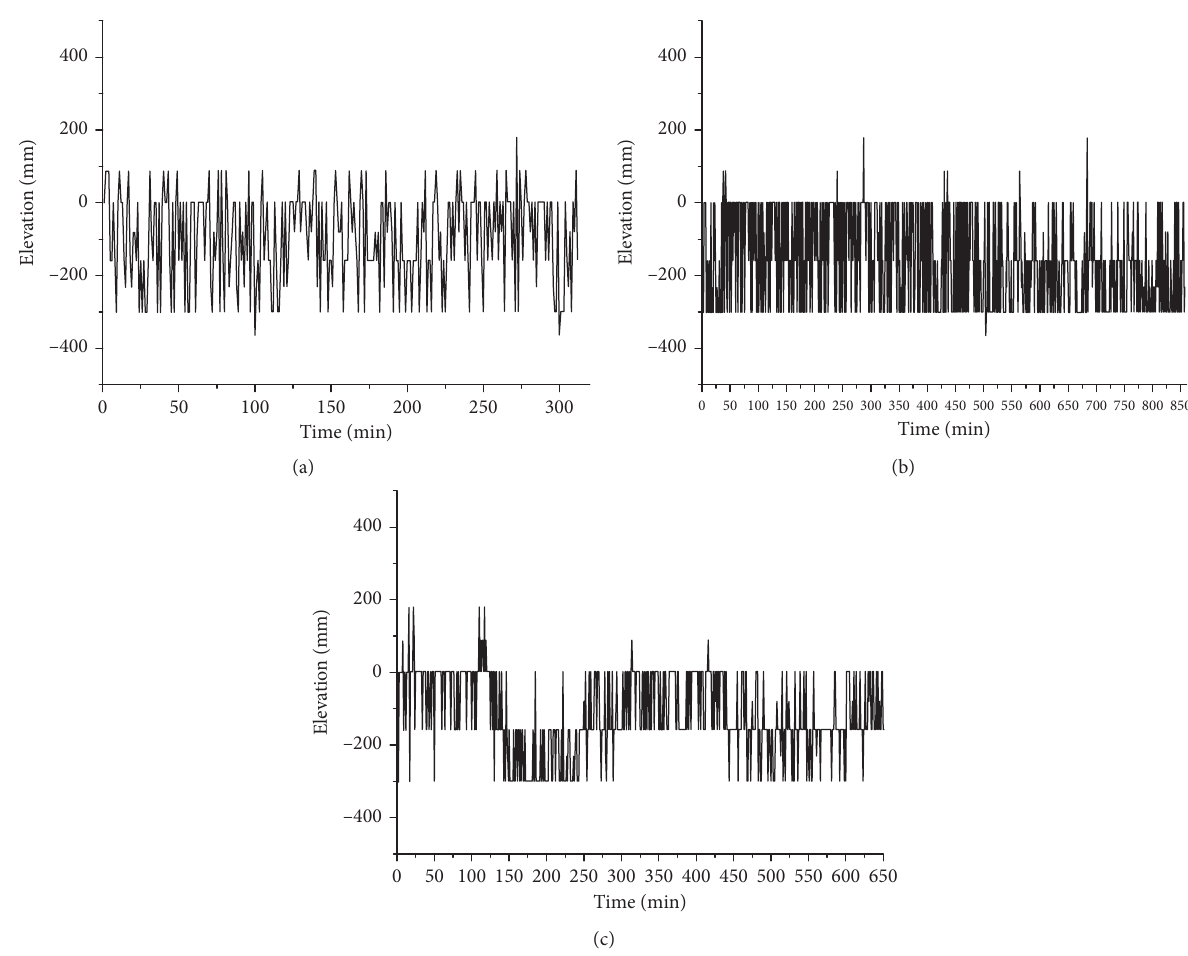
Figure 26: Real-time elevations of the main girder at the anchorage of 2# stayed cable. (a) Sample calculated for repair step 1. (b) Sample calculated for repair step 2. (c) Sample calculated for repair step